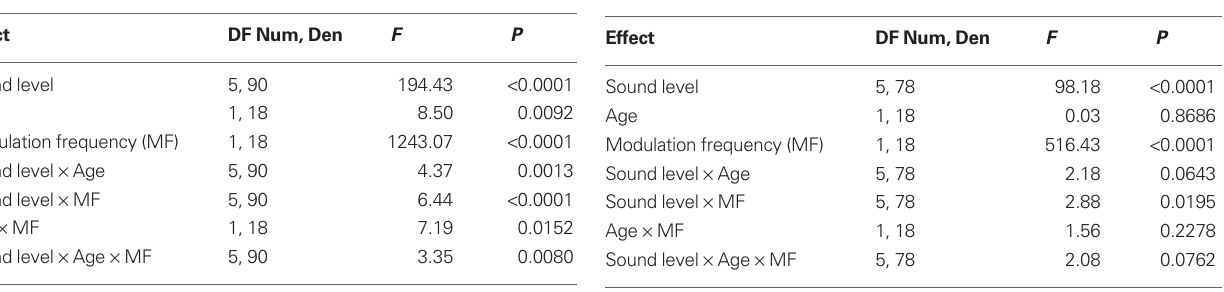
Table 1 | Tests of main effects of sound level, age and modulation frequency, as well as all their interaction factors on AMFr amplitudes using repeated measures ANOVA.